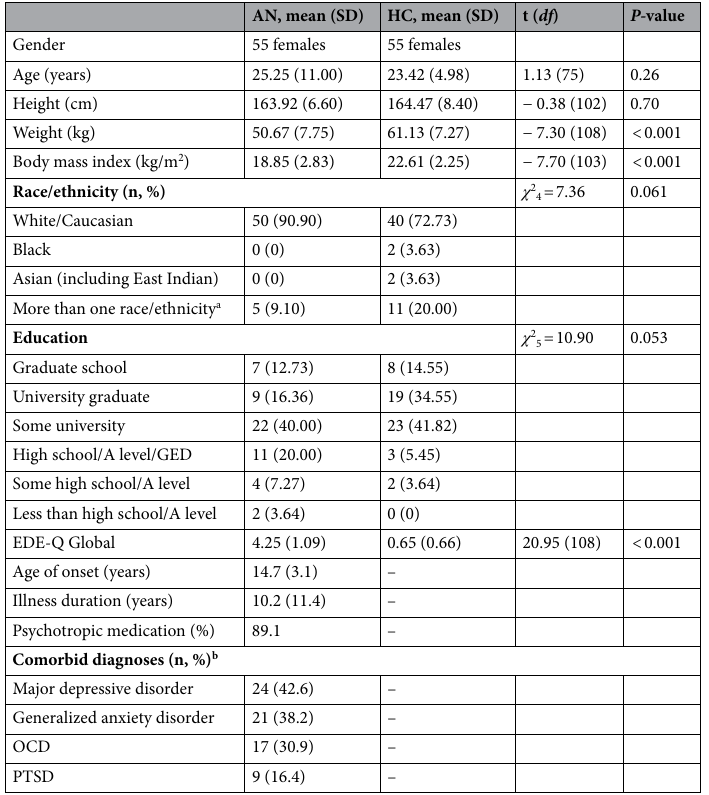
Table 1. Demographic and clinical characteristics of anorexia nervosa inpatients and healthy comparisons. GED general educational development, OCD obsessive compulsive disorder, PTSD posttraumatic stress disorder. a Hispanic/Latino descent, Lebanese, American Indian/Alaska Native, Native Hawaiian or other Pacific Islander, Jewish, Black, White/Caucasian, Asian (including East Indian) listings per the PhenX 34 . b For brevity, only comorbid diagnoses with > 10% frequency are